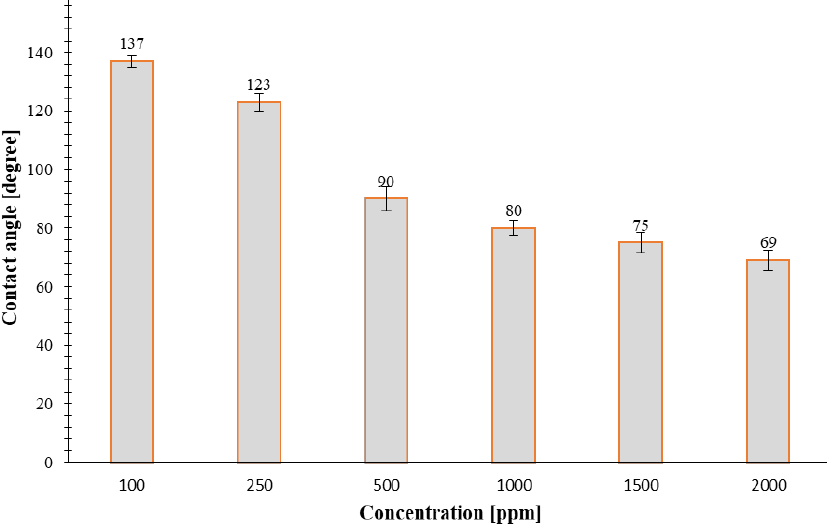
Figure 16. Effect of the prepared nanofluids with different concentrations of the novel NC on wettability (contact angle) of the sandstone rock samples.